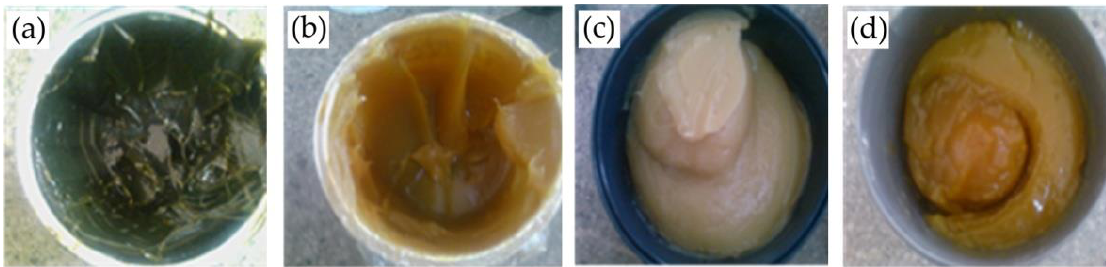
Figure 3. ( a ) Digital microhardness device, ( b ) formed parts, ( c ) three zones of hardness measure- ment, ( d ) hardness test sample of the formed part .